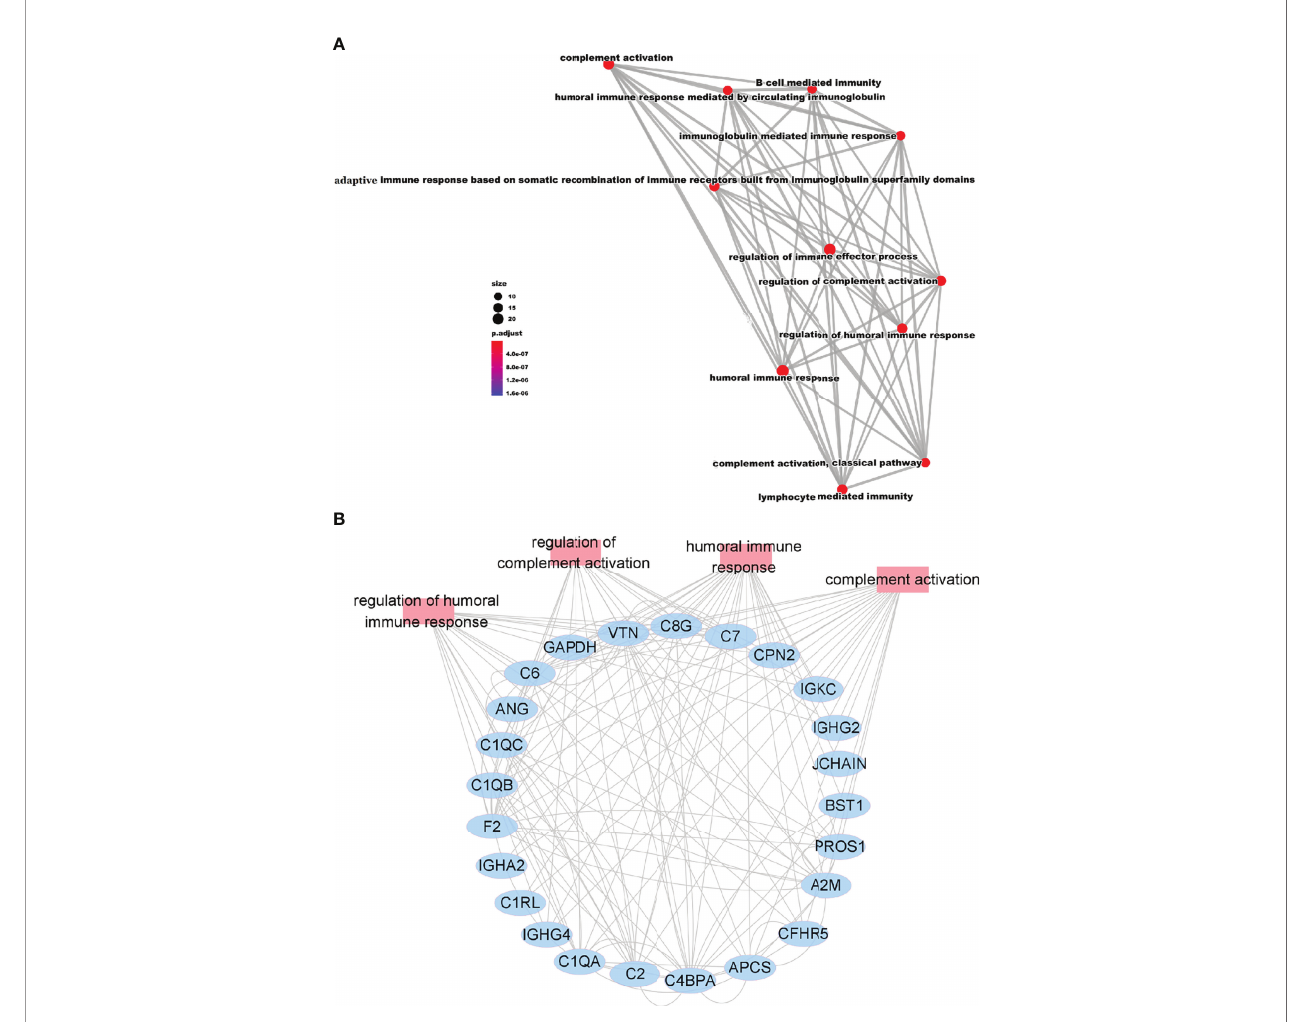
FIGURE 3 | Correlation Analysis of the Immune-Related Proteins. (A) Network of GO modules related to the immune response de fi ned by BINGO. (B) Interaction diagram of proteins involved in the humoral immune response, regulation of complement activation, humoral immune response, and regulation of complement